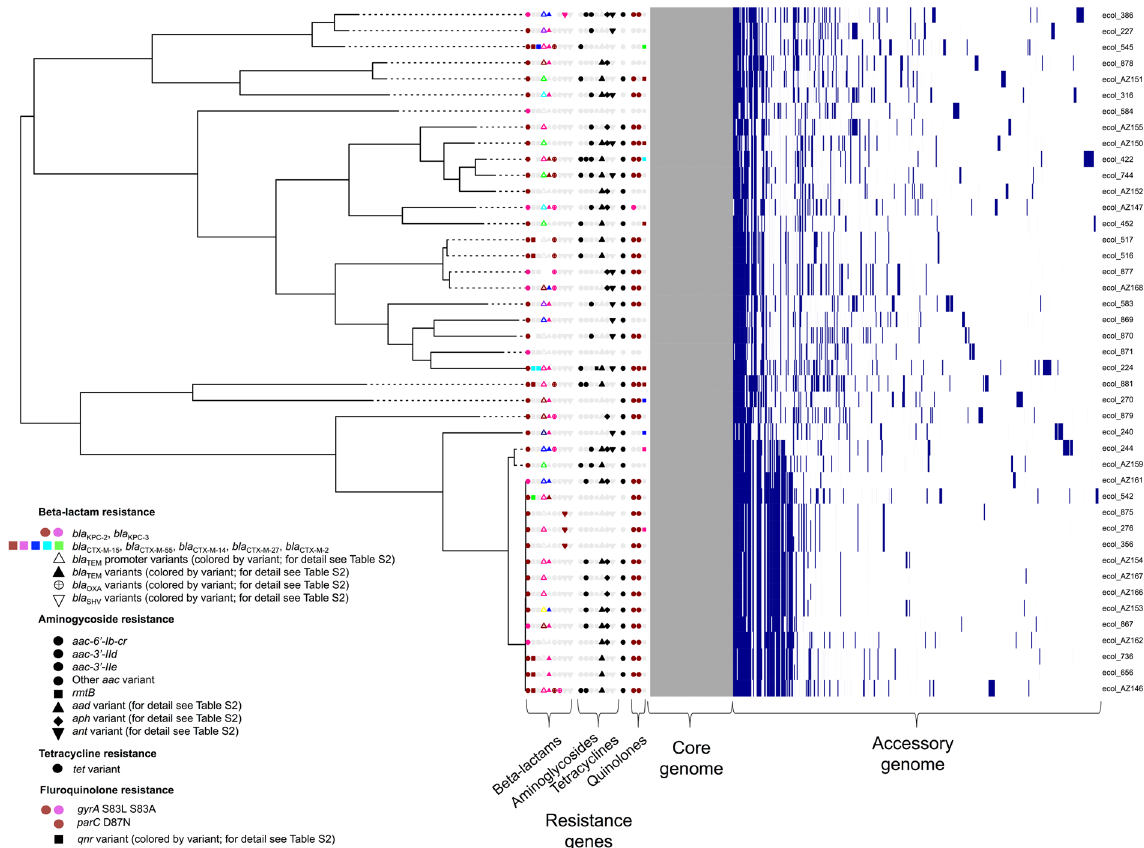
Figure 1. Phylogeny of KPC- Escherichia coli identified from global carbapenem resistance surveillance schemes, 2008–2013. Panels to the right of the phylogeny represent common resistance gene mechanisms (full details of resistance gene typing in Table S2), core and accessory genome components. For the accessory genome panel, blue represents annotated regions that are present, and white those that are